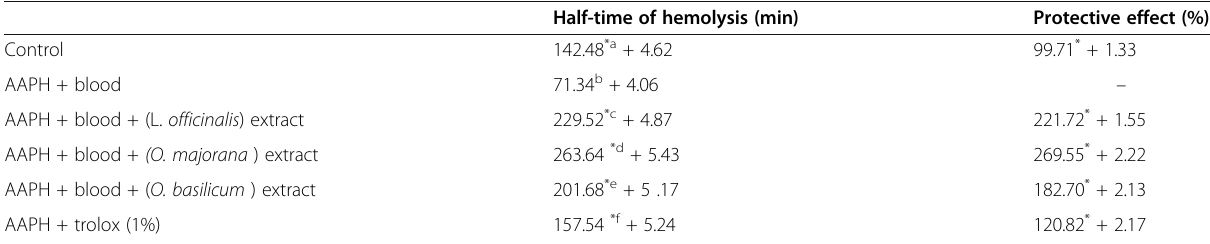
Table 2 Antihemolytic activity of aqueous extracts of three Lamiaceae species against AAPH induced